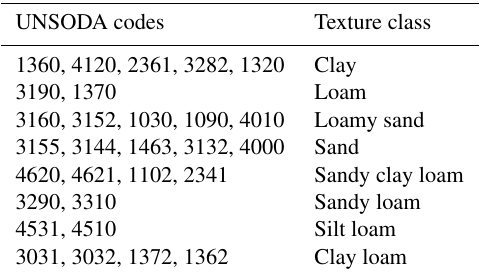
Table 4. Codes of the 29 soil samples selected from UNSODA for the model